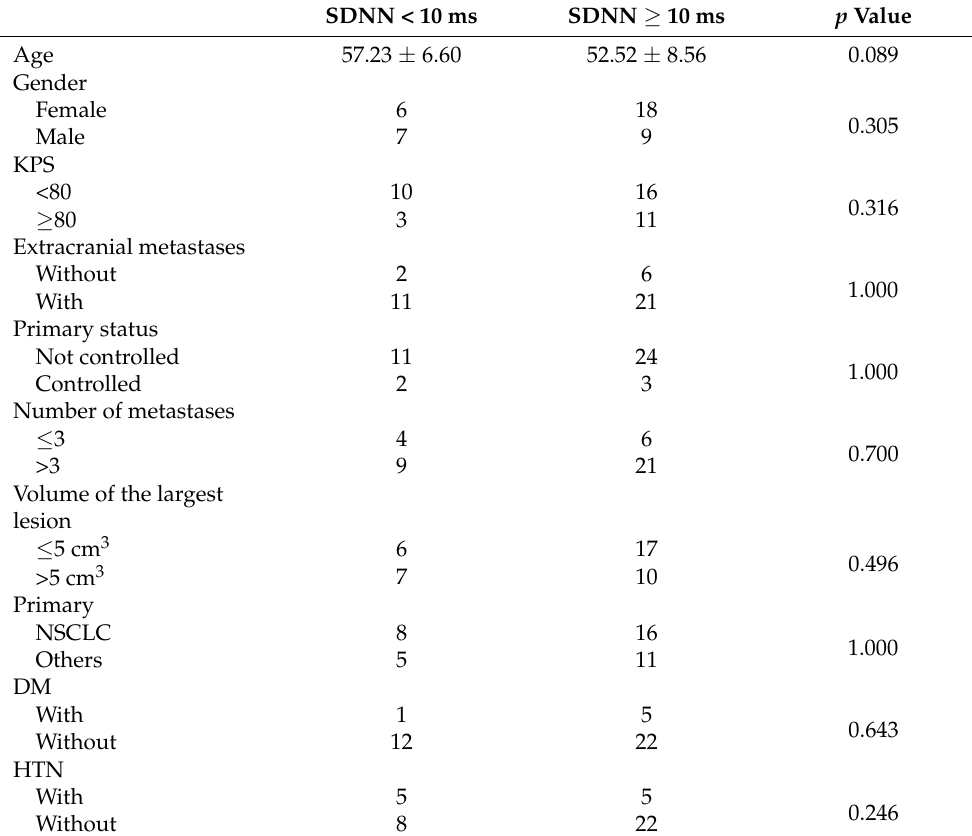
Table 2. Comparison of parameters between SDNN